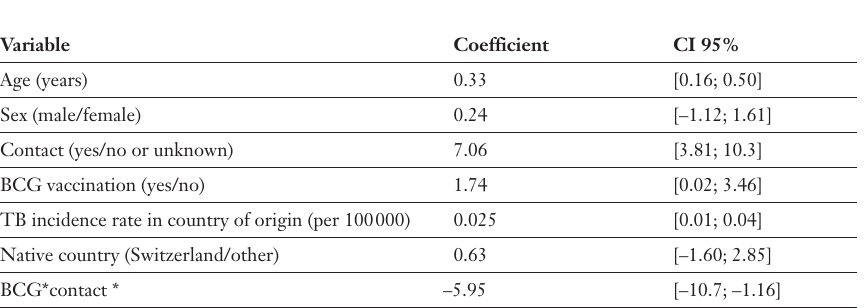
Table 2 Linear regression analysis of risk fac- tors for Tuberculin Skin Test